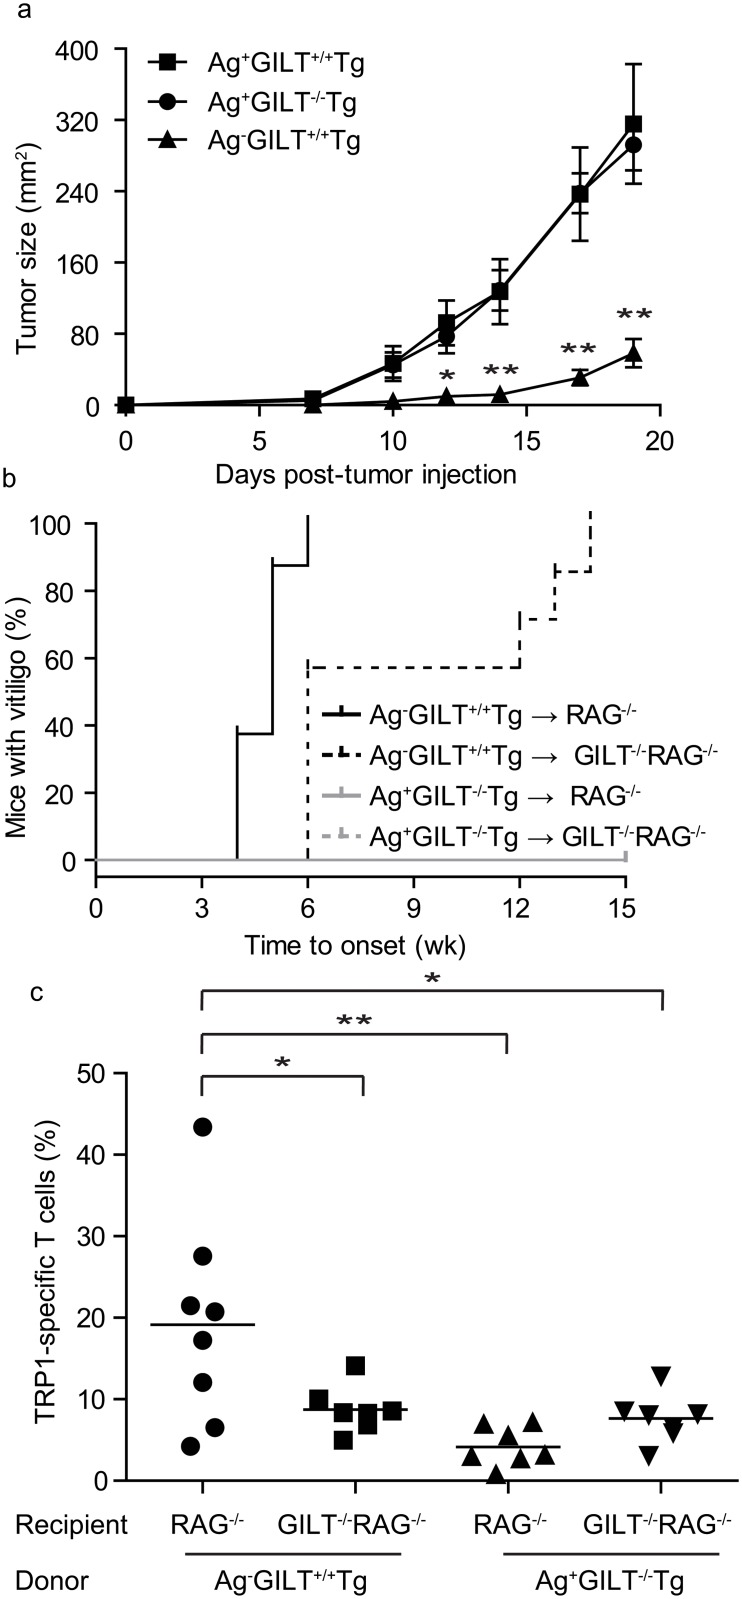
Melanoma-specific T cells that develop in the presence of a self/melanoma antigen lack anti-melanoma and autoimmune activity.
(a) B16 melanoma cells were subcutaneously injected into Ag+GILT+/+Tg, Ag+GILT-/-Tg and Ag-GILT+/+Tg mice and followed for tumor growth. Data are representative of two independent experiments with five mice per group and compared by ANOVA with the Tukey correction for multiple comparisons (*p<0.05; **p<0.01). (b) CD4+ cells from Ag-GILT+/+Tg and Ag+GILT-/-Tg mice were injected into the tail vein of Ag-expressing RAG1-/- or GILT-/-RAG1-/- recipients, and animals were followed for vitiligo onset. Disease onset curves were compared using the log-rank test. The onset of autoimmunity caused by T cells from Ag-GILT+/+Tg mice was delayed in GILT-deficient hosts compared with RAG1-/- hosts (p<0.01). T cells from Ag+GILT-/-Tg mice failed to induce vitiligo in all recipients. (c) Fifteen weeks after the adoptive transfer in b, skin-draining lymph node cells from recipient animals were gated on lymphocytes and analyzed for TRP1-specific T cells identified by CD4 and Vβ14 expression. Data are shown from three pooled experiments compared by ANOVA with the Tukey correction for multiple comparisons (*p<0.05; **p<0.01).